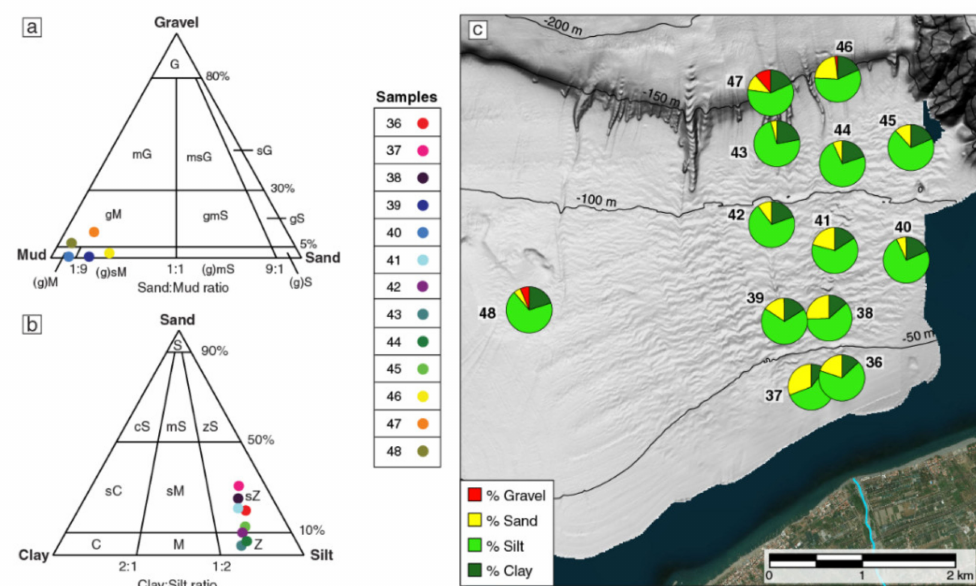
Figure 2. Ternary diagrams for the sediment samples collected in the study area. Sediment classification scheme from [48,49]. ( a ) Samples with >0.1% gravel; ( b ) samples with no gravel; ( c ) pie charts showing the proportion of gravel, sand, silt and clay for each sample. G—gravel; g—gravelly; (g)—slightly gravelly; S—sand; s—sandy; M—mud; m—muddy; Z—silt; z—silty; C—clay;